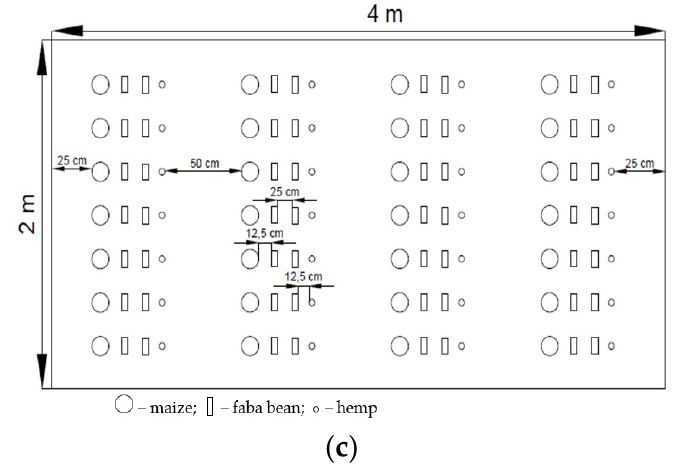
Figure 1. The sowing scheme of single ( a ), binary ( b ) and ternary ( c ) cultivations [30].